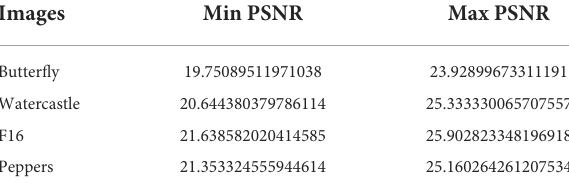
TABLE 1 The range of PSNR-best values for each image. The min PSNR and max PSNR represent the minimum and maximum PSNR-best among all experiments,